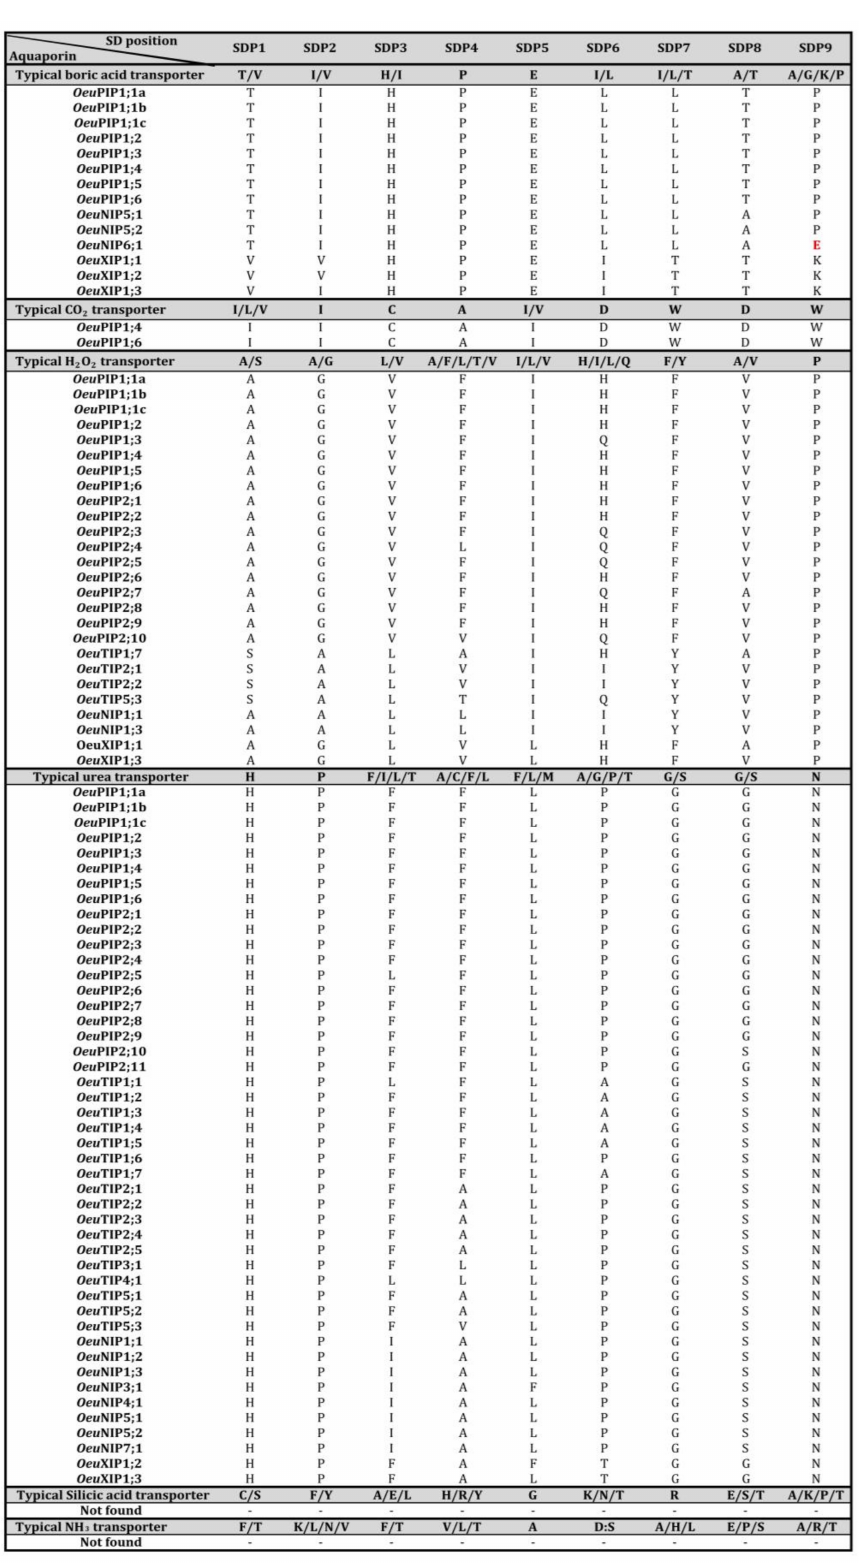
Figure 4. Summary of typical specificity-determining positions (SDPs) and those identified in the complete sequences of Oeu AQPs from the wild olive species Olea europaea var. sylvestris . The red residue represents a putative novel site. Amino acid alignments of the Oeu AQPs transporting non-aqua substrates where SDP signatures were identified are shown in Figure